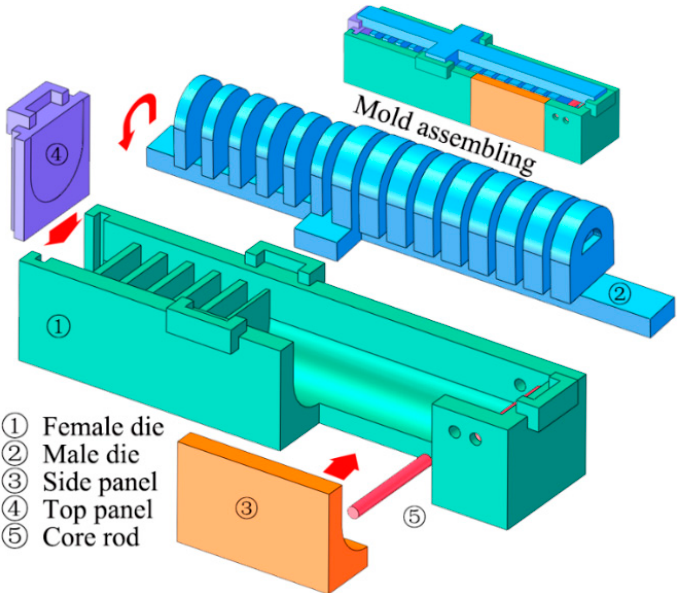
Figure 11. Components of the designed molds for the fabrication of the proposed soft actuator.